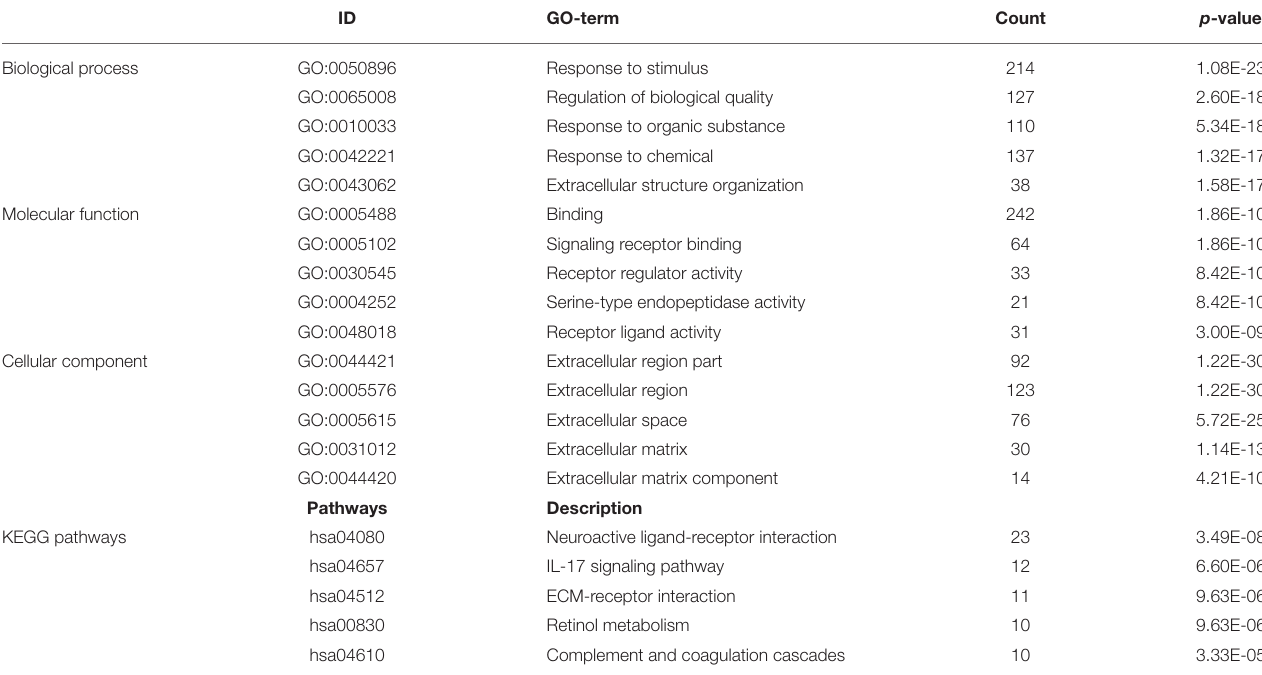
TABLE 2 | Module 2 GO and KEGG pathways analysis. ID p